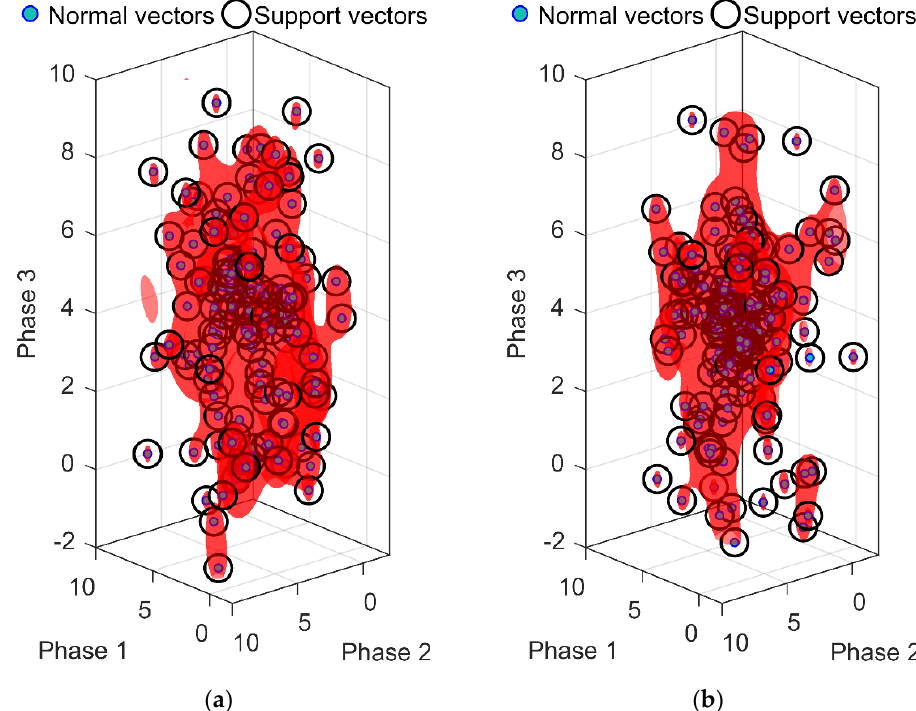
Figure 5. Trained OCSVM and the vectors in an input phase space ( L = 3) with ( a ) Gaussian noise and ( b ) Laplacian noise. Red plane is the 3D contour plane.